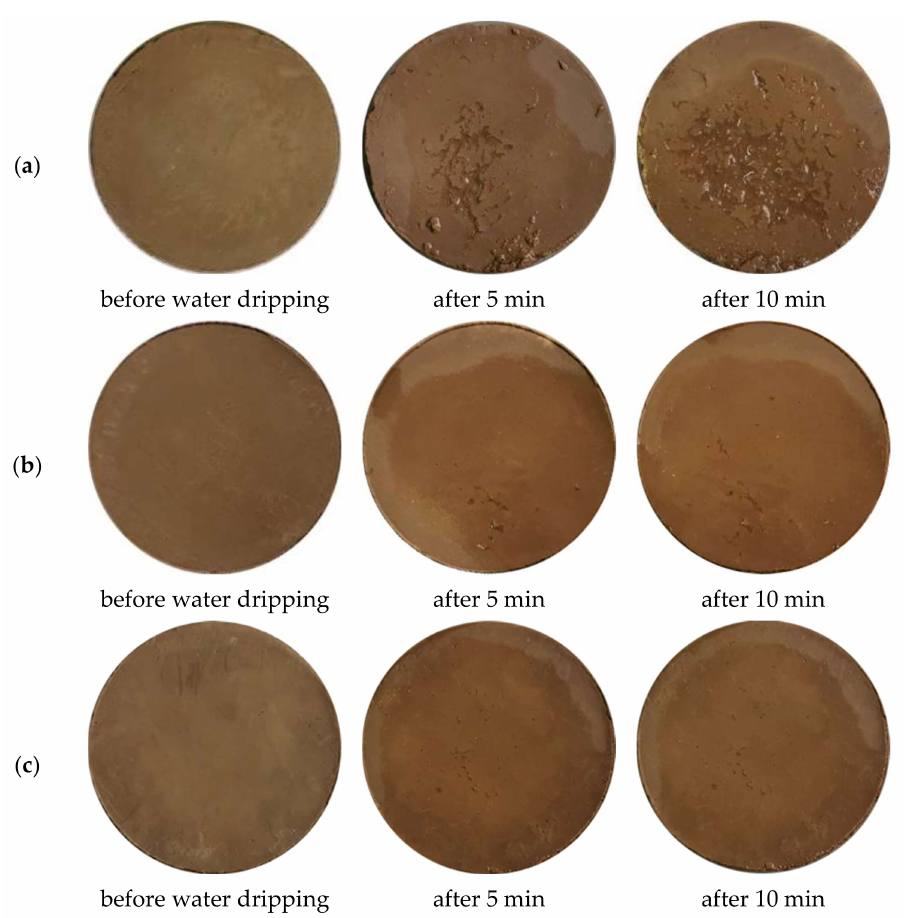
Figure 9. Clay composite surfaces after water erosion test. ( a ) Untreated control sample; ( b ) RSH 2.5(3); ( c ) RSH